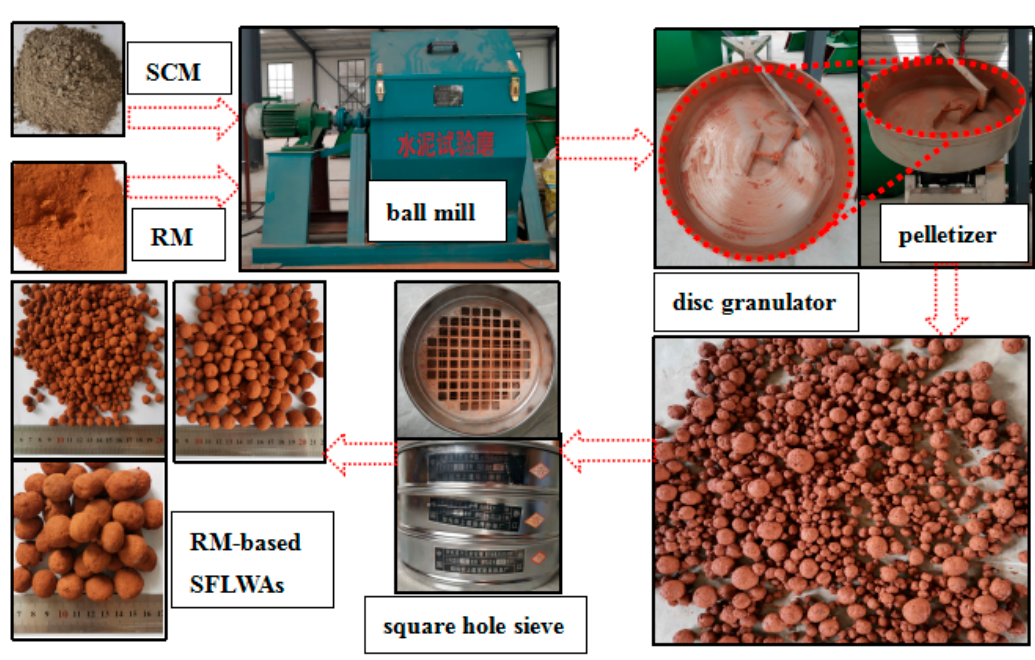
Figure 3. Preparation process of RM-based sintering-free lightweight aggregates (SFLAs) through cold bonded granulation used in this work.